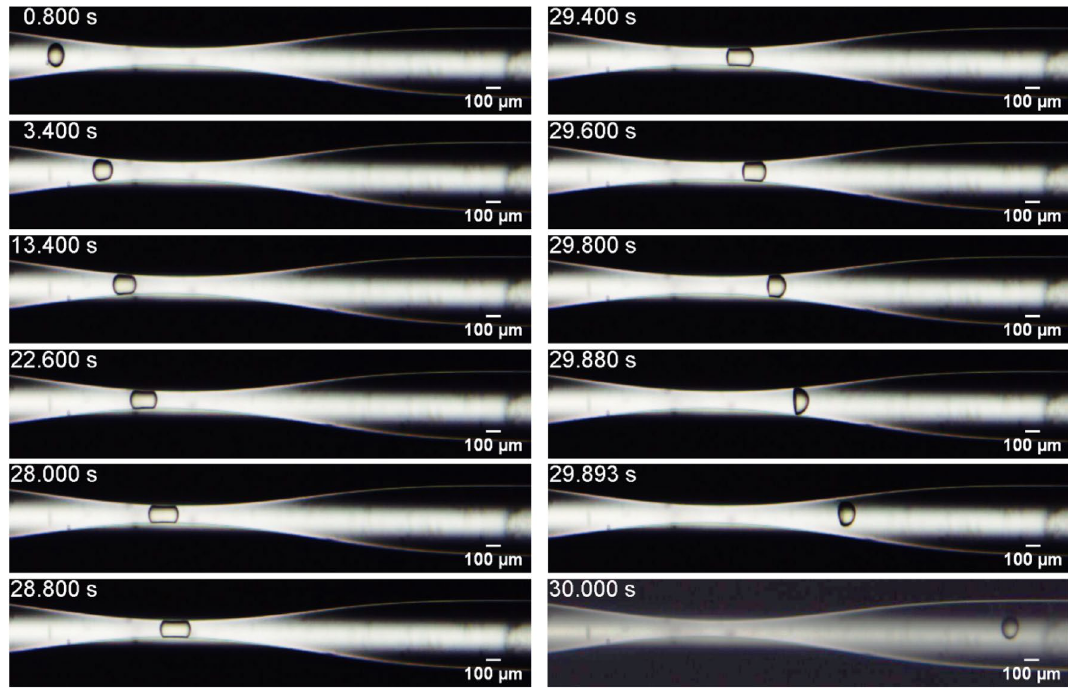
Figure 1. Evolution of the microcapsule position and configuration as it flows through the constriction. System #3, D = 144.4 μm and h = 15.2 μm ( a = 1.44 and Ca s = 5.9 × 10